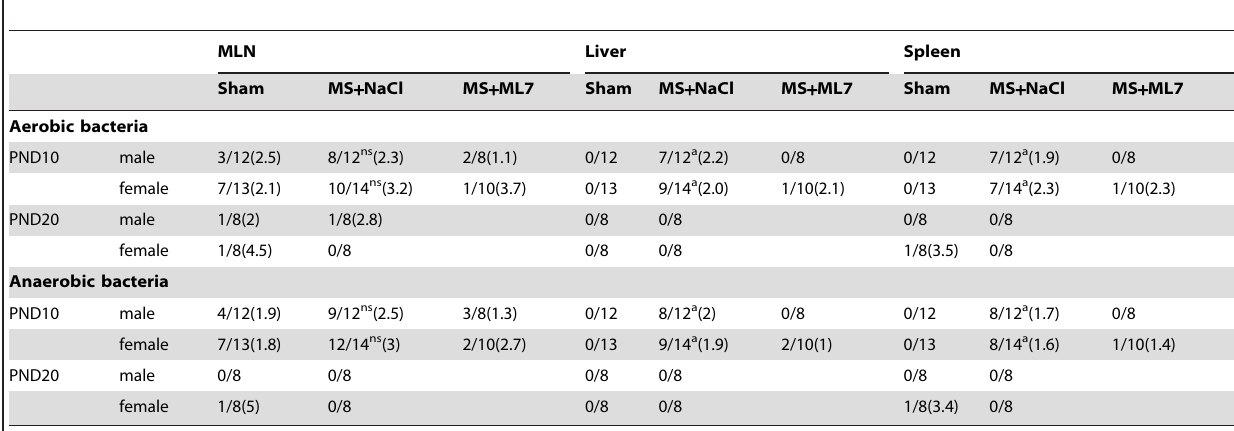
Table 1. Comparative effects of single MS on bacterial translocation into the MLN, liver and spleen at PND10 and PND20.